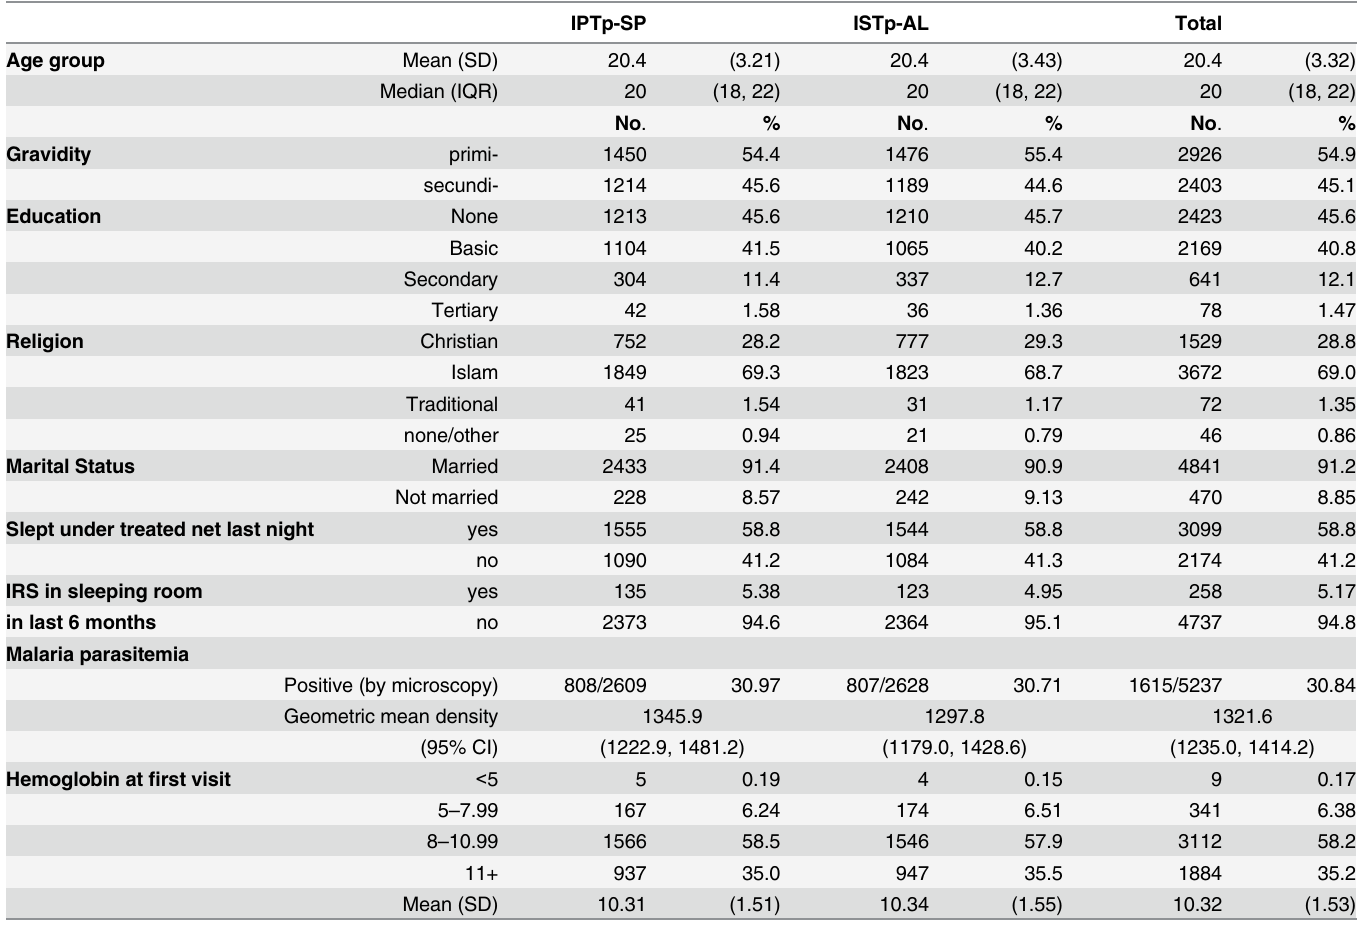
Table 1. Baseline characteristics of the study